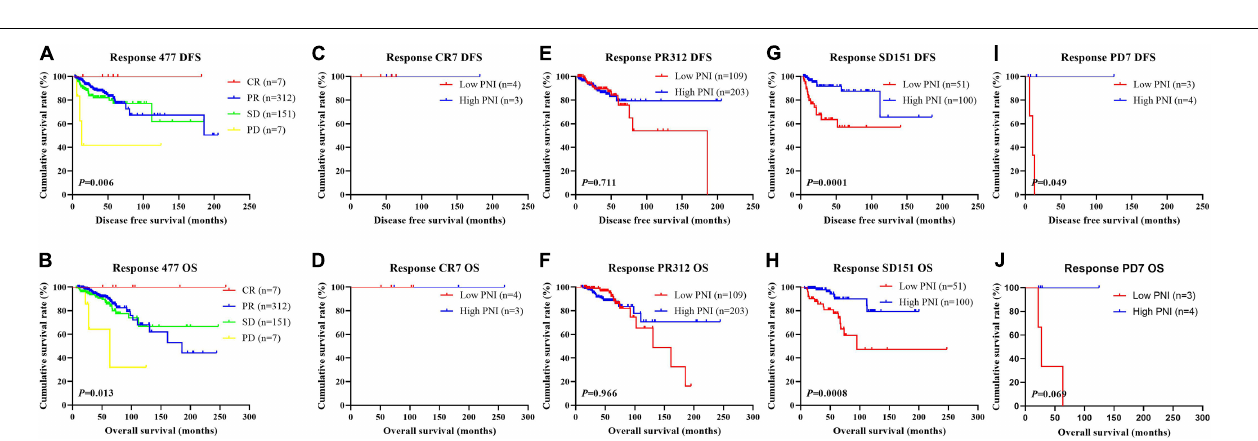
FIGURE 9 | Disease-free survival (DFS) and overall survival (OS) for the prognostic nutritional index (PNI) of patients with breast cancer in Miller and Payne grade (MPG) in the neoadjuvant chemotherapy (NACT) group. (A,B) Kaplan-Meier analysis of DFS (A) and OS (B) for the PNI of patients with different MPG in NACT group. (C,D) Kaplan-Meier analysis of DFS (C) and OS (D) for the PNI of patients with MPG 1 in NACT group. (E,F) Kaplan-Meier analysis of DFS (E) and OS (F) for the PNI of patients with MPG 2 in NACT group. (G,H) Kaplan-Meier analysis of DFS (G) and OS (H) for the PNI of patients with MPG 3 in NACT group. (I,J) Kaplan-Meier analysis of DFS (I) and OS (J) for the PNI of patients with MPG 4 in NACT group. (K,L) Kaplan-Meier analysis of DFS (I) and OS (J) for the PNI of patients with MPG 5 in NACT group.